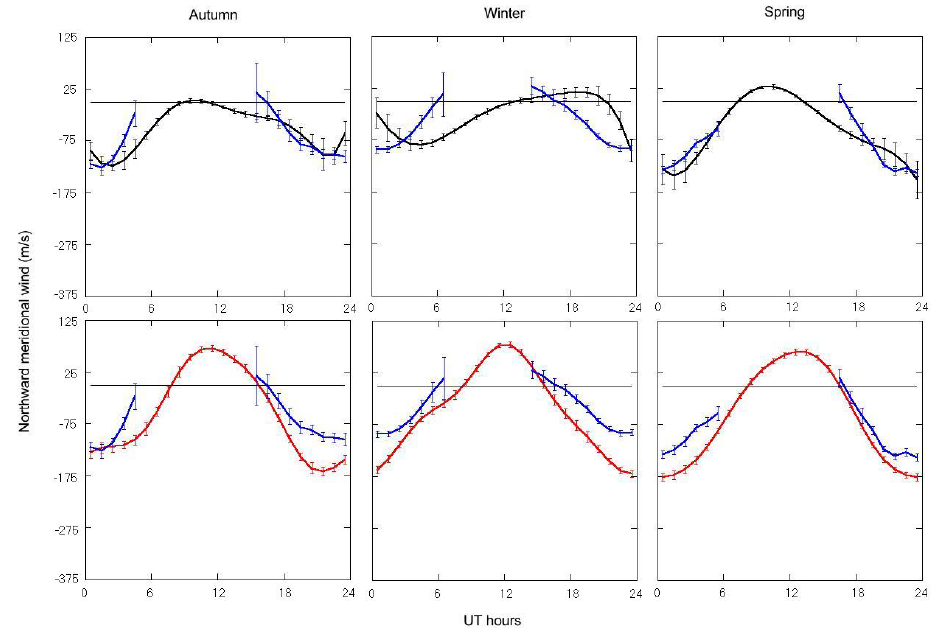
Fig. 10. Climatological comparisons for the low solar activity case with the top three plots comparing EISCAT-MWM (black lines) to FPI climatologies (blue lines) and the bottom three plots comparing EISCAT-ISR (red lines) to FPI climatologies for each of three